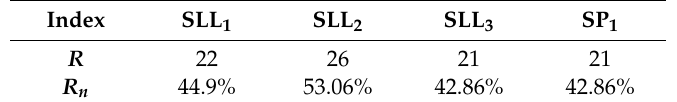
Table 5. Stability index over 49 contingencies in maine.